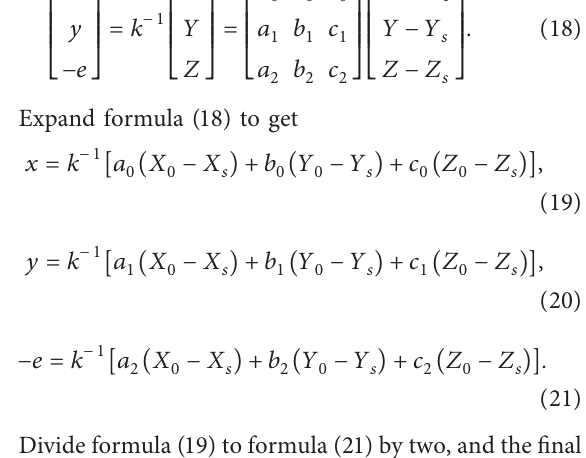
Table 1: Measuring point coordinates and accuracy statistics